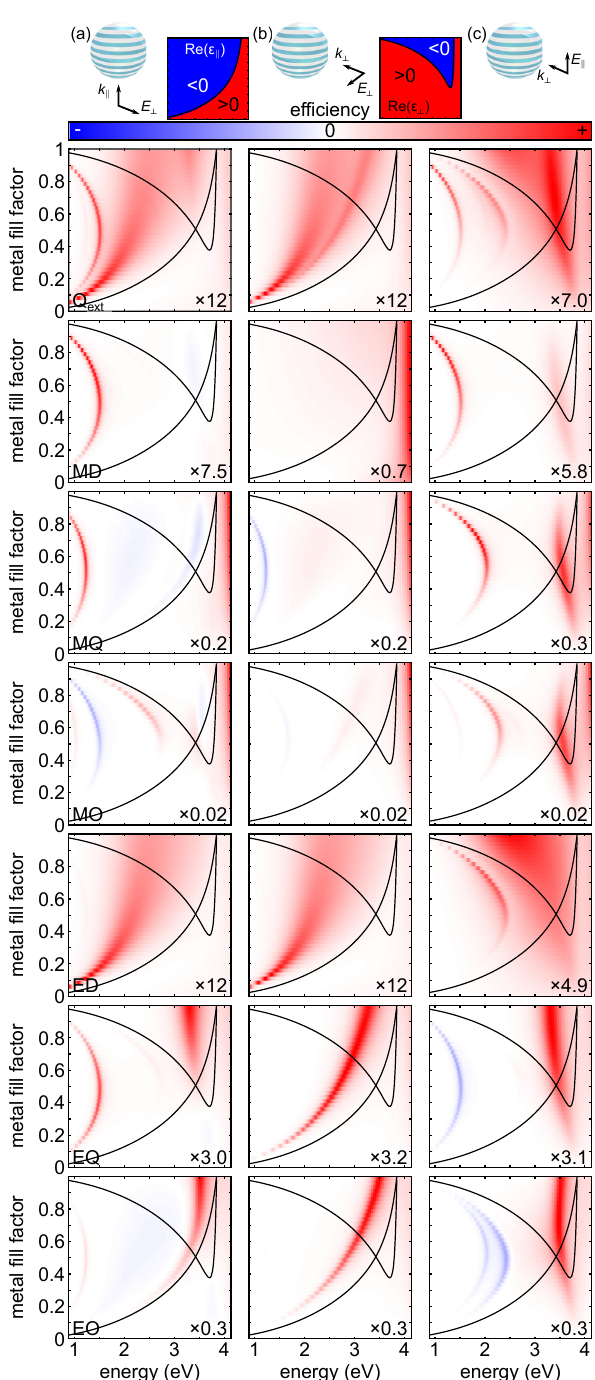
Figure 6: Optical properties of hyperbolic nanospheres, r = 80 nm, for the three unique illumination conditions vs energy and metal filling fraction: Extinction efficiency, Q , its decomposition into the ext first six moments: MD, MQ, MO, ED, EQ, and EO. Black lines mark regions with positive/negative permittivity tensor elements. Note Figure 7: T -matrix derived coupling between multipoles in an the monotonic behavior of the mainly uncoupled electric modes with anisotropic nanosphere with r = 80 nm and n , while the magnetic resonances in the hyperbolic dispersion f m extinction is plotted in Figure 6. The actual coupling between range in all cases coupled to other modes. Furthermore, often the multipoles in Figure 6 depends on the incident field direction and coupled modes of high order occur below the lower order modes of the same type, e.g. EQ below ED for TEM polarization.